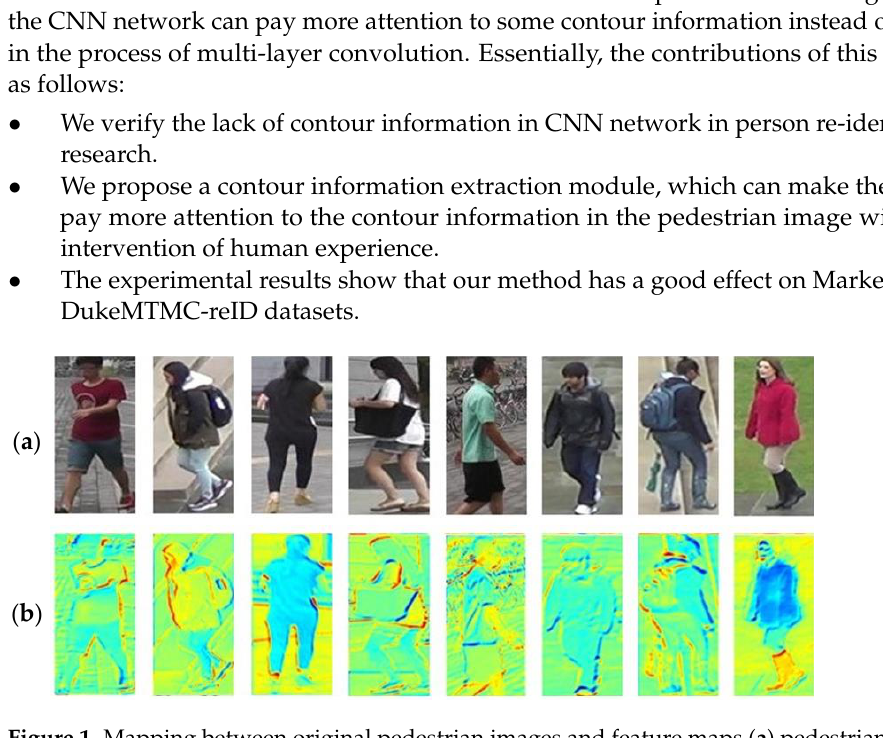
Figure 1. Mapping between original pedestrian images and feature maps ( a ) pedestrian images in common datasets. ( b ) Shallow features of RGB images in ResNet-50 network.